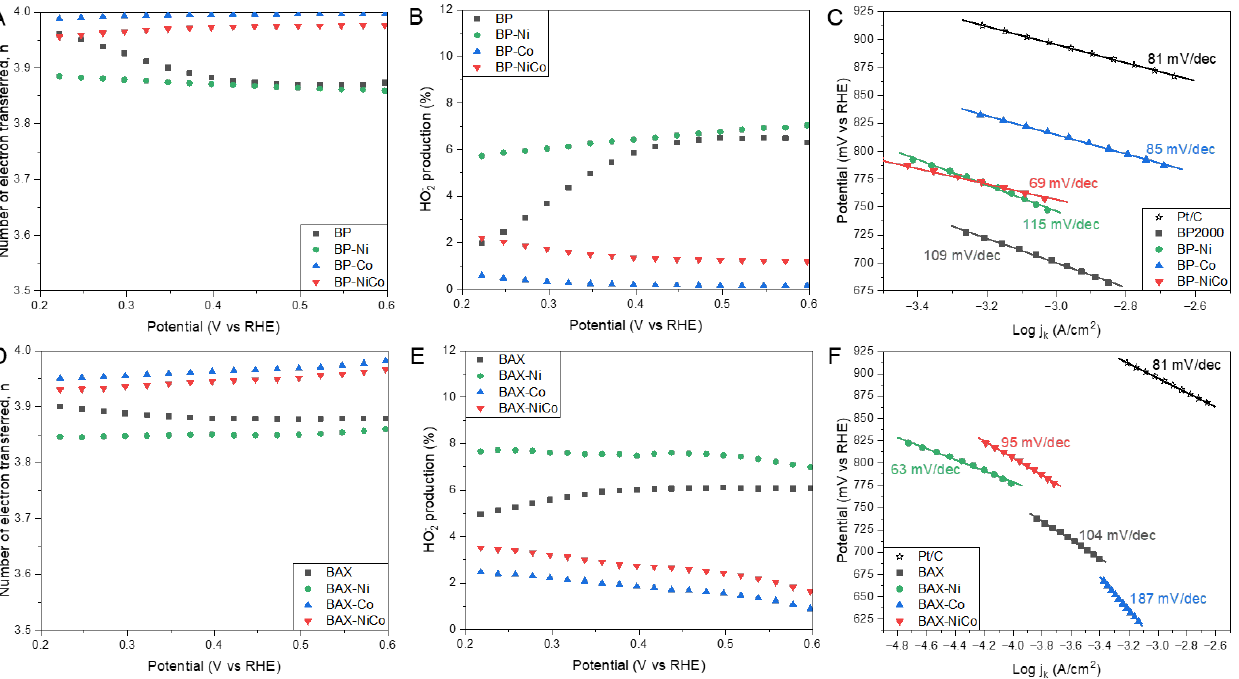
Figure 3. The number of electrons transferred on the BP series samples ( A ) and the BAX ones ( D ); percent of HO − 2 formed in the BP series samples ( B ) and the BAX ones ( E ); Tafel plot for the BP series samples ( C ) and the BAX ones ( F ).